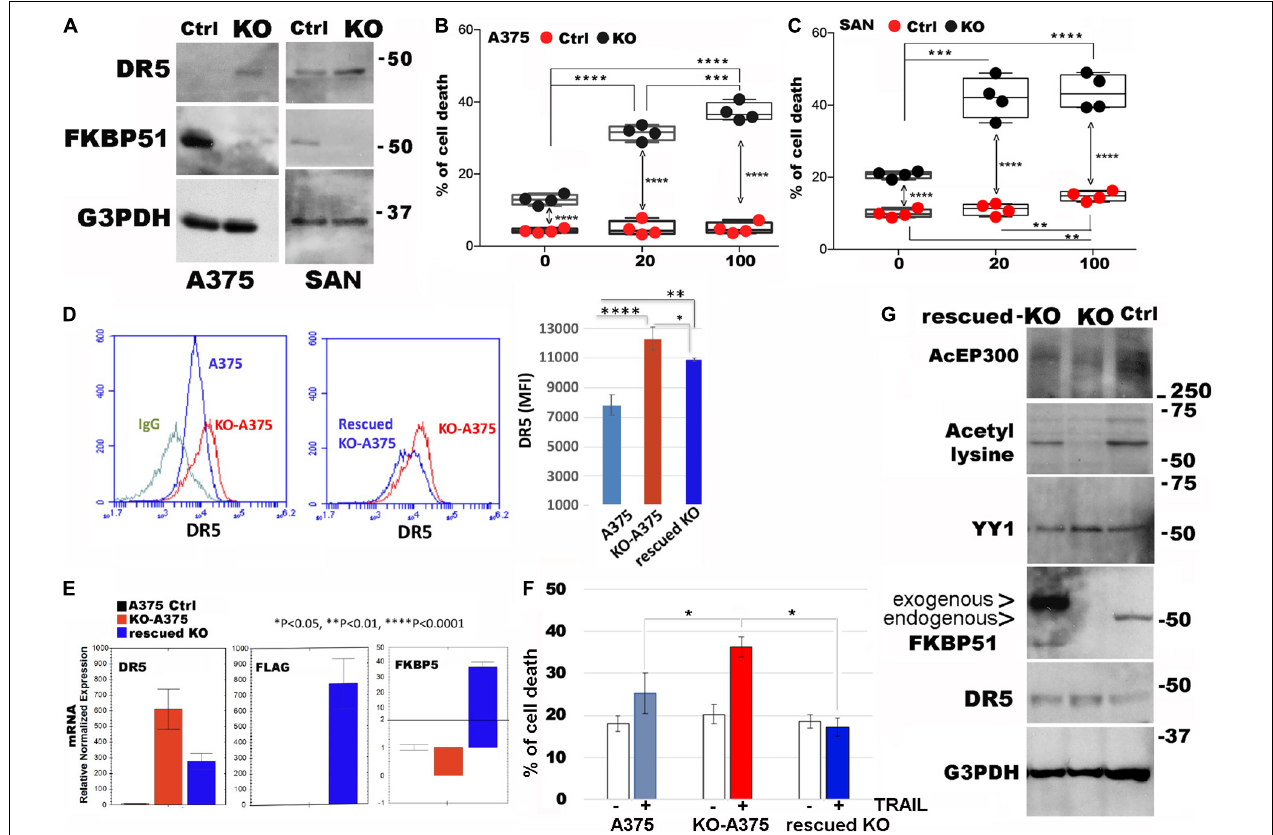
FIGURE 5 | Ectopic FKBP51 counteracts DR5 upregulation in Crispr/Cas9-knockout (KO). (A) Western blot assay of DR5 levels in Crispr/Cas9 KO-A375, and KO-SAN cell lines. Graphic representation of flow cytometric values of cell death in A375 (B) and SAN (C) melanoma cell cultures with 20 and 100 ng/ml TRAIL (each bullet represents the mean of triplicates). (D) Left, flow cytometric histograms in overlay of DR5 expression, measured in A375 or KO-A375 or FKBP51-rescued KO-A375 cells. The histogram of KO-A375 moves to the right of that of wtA375, indicating increased expression. The histogram of rescued KO-A375 moves to the left of that of KO-A375, indicating reduced expression. Right, mean ± SD ( N = 3) of DR5 mean fluorescence intensities (MFI). (E) Measurement by qPCR of DR5mRNA, Flag mRNA, and FKBP5 mRNA in the same cells as in panel (B) . (F) Graphic representation of flow cytometric values of cell death in A375, KO-A375 and rescued KO-A375 melanoma cell cultures with 100 ng/ml TRAIL ( N = 3). (G) Western blot assay of acEP300, acetyl-lysine, YY1 and DR5 levels in A375, KO-A375 and FKBP51-rescued KO-A375 cells. * p < 0.05, ** p < 0.01, *** p < 0.001, **** p <